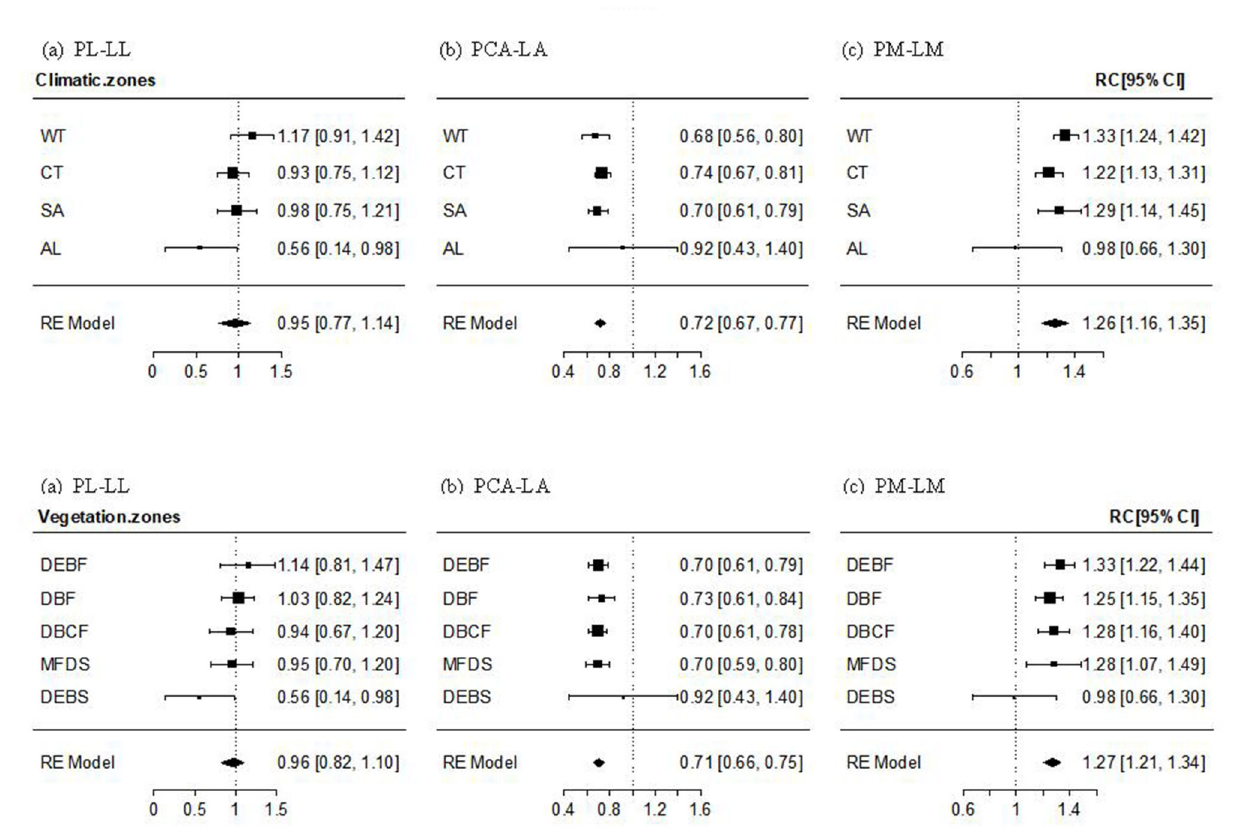
FIGURE 2 | Mean effect size and 95% intervals of the relationship between petiole length and lamina length (PL–LL, a ), between petiole crosssectional area [PCA and lamina area (PCA–LA, b )], and between petiole mass and lamina mass (PM–LM, c ) for different climate zones and vegetation types. WT, warm-temperate; CT, cool-temperate; SA, subalpine; AL, alpine; DEBF, deciduous-evergreen broadleaf forest; DBF, deciduous broadleaf forest; DBCF, deciduous broadleaf-conifer forest; MFDS, mixed forest-deciduous shrub; DEBS, deciduous-evergreen broadleaf